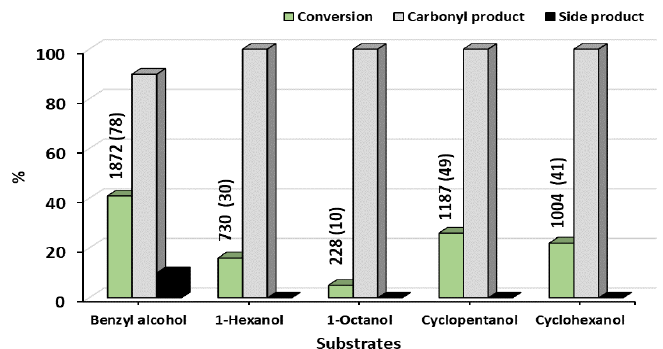
Figure 8. Scope and limitations with turn over number (TON, in parentheses TOF h − 1 ); conversion is based on substrate; substrate (100 mmol); TBHP (0.15 mmol); temperature (90 °C); O 2 balloon 1 atm; amount of catalyst (100 mg); time (24 h).